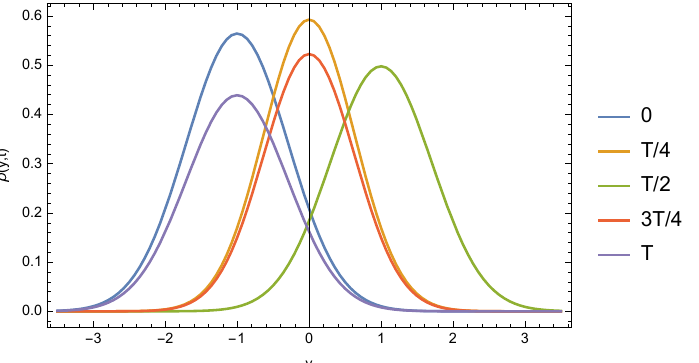
Figure 1. The dissipation caused shape damping of the distribution ρ ( x , t ) of the damped oscillator in one time period. The applied parameter set is m = 1; ¯ h = 1; ω = 1, γ = 0.8, λ = 0.01. The time period is T = 2 π / ω . The peak of the initial distribution is at y 0 = −